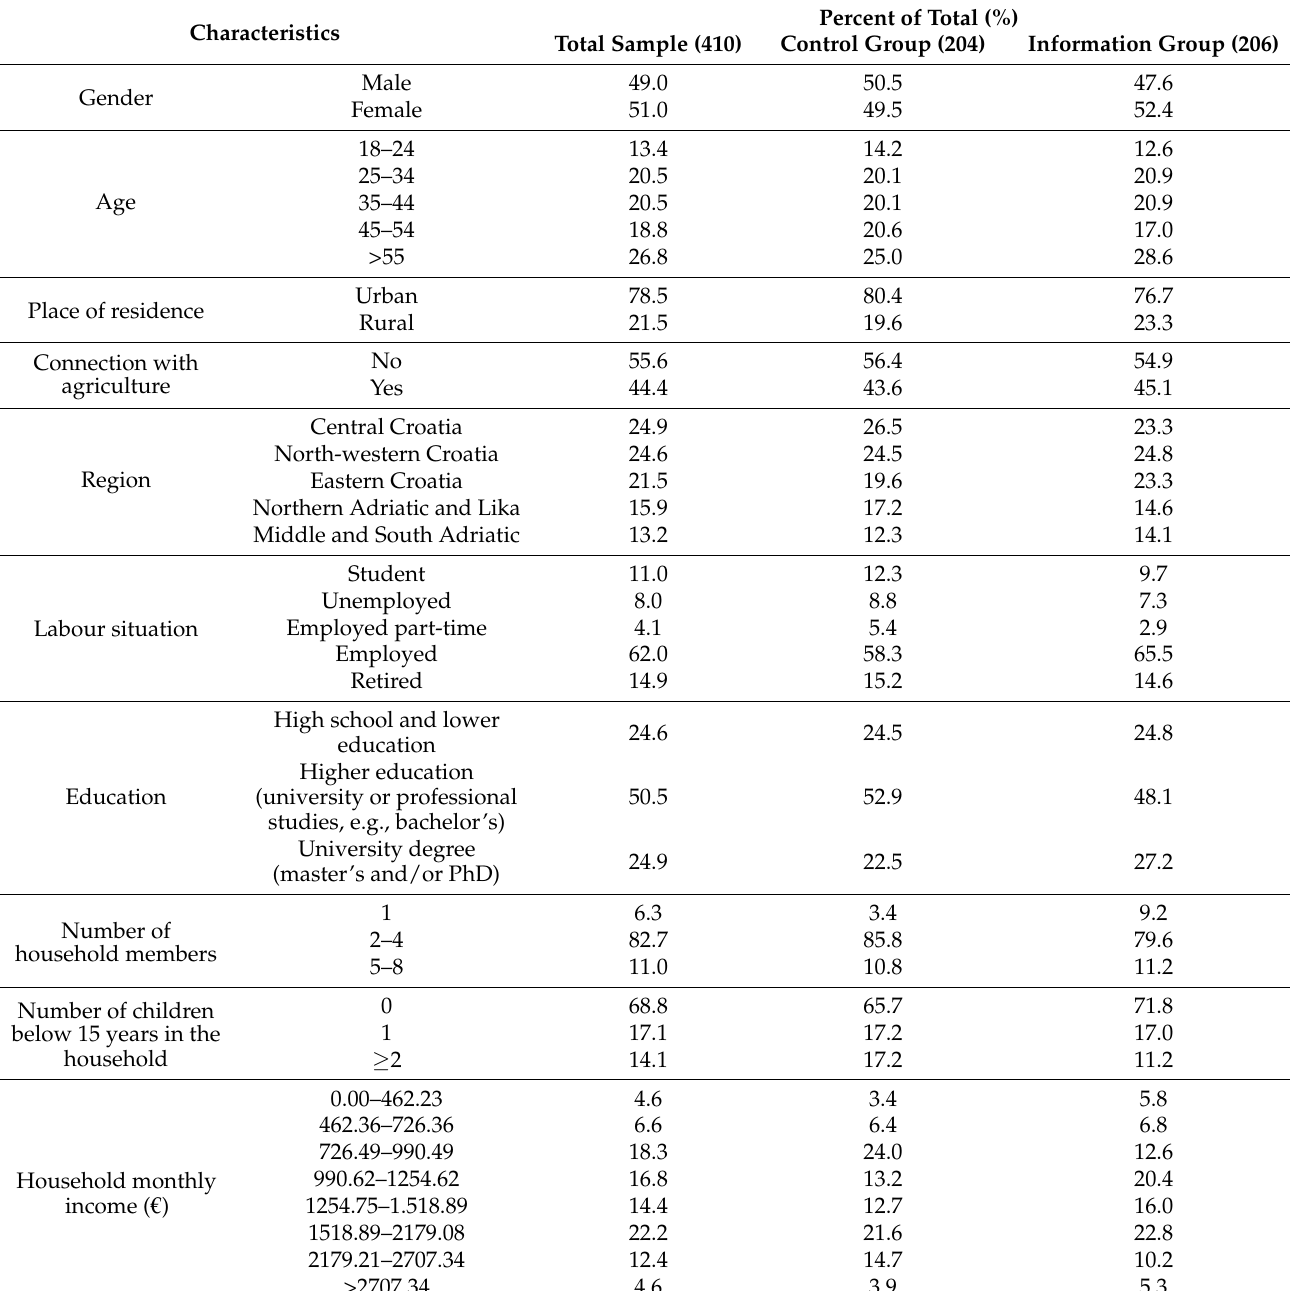
Table 2. Main descriptive statistics of the respondents’ sociodemographic